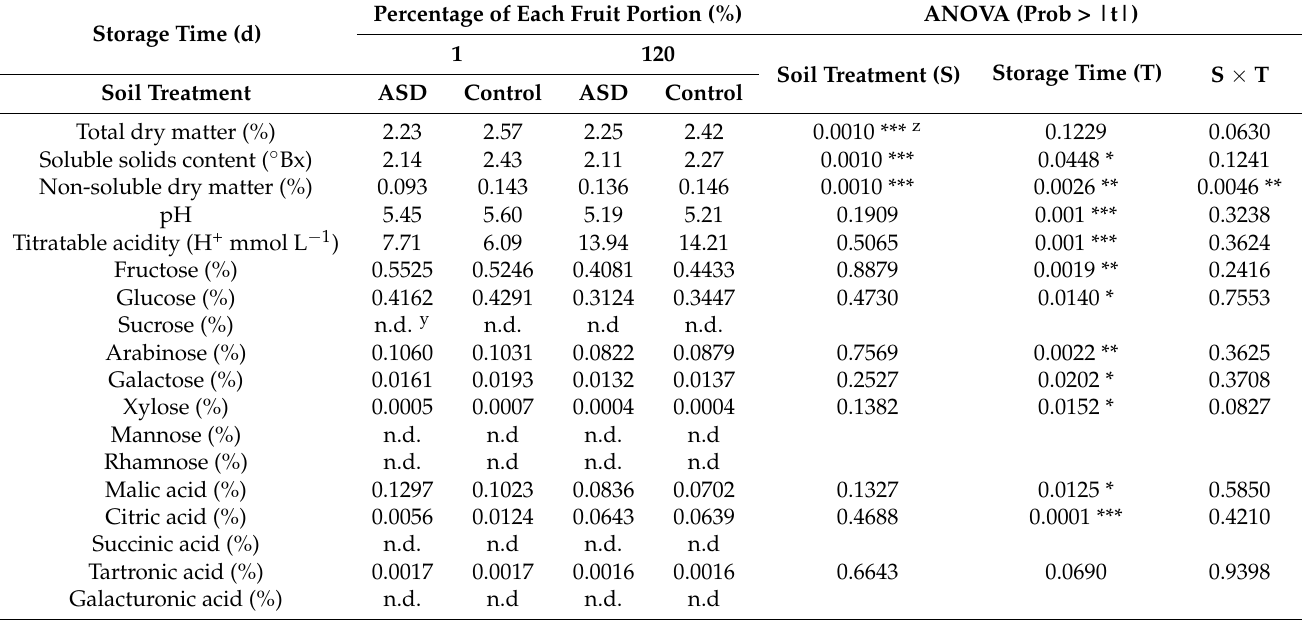
Table 3. Effect of soil treatment and storage time on total dry matter, soluble solids content, pH, titrat- able acidity, non-soluble dry matter and individual sugars and acids of winter melon juice